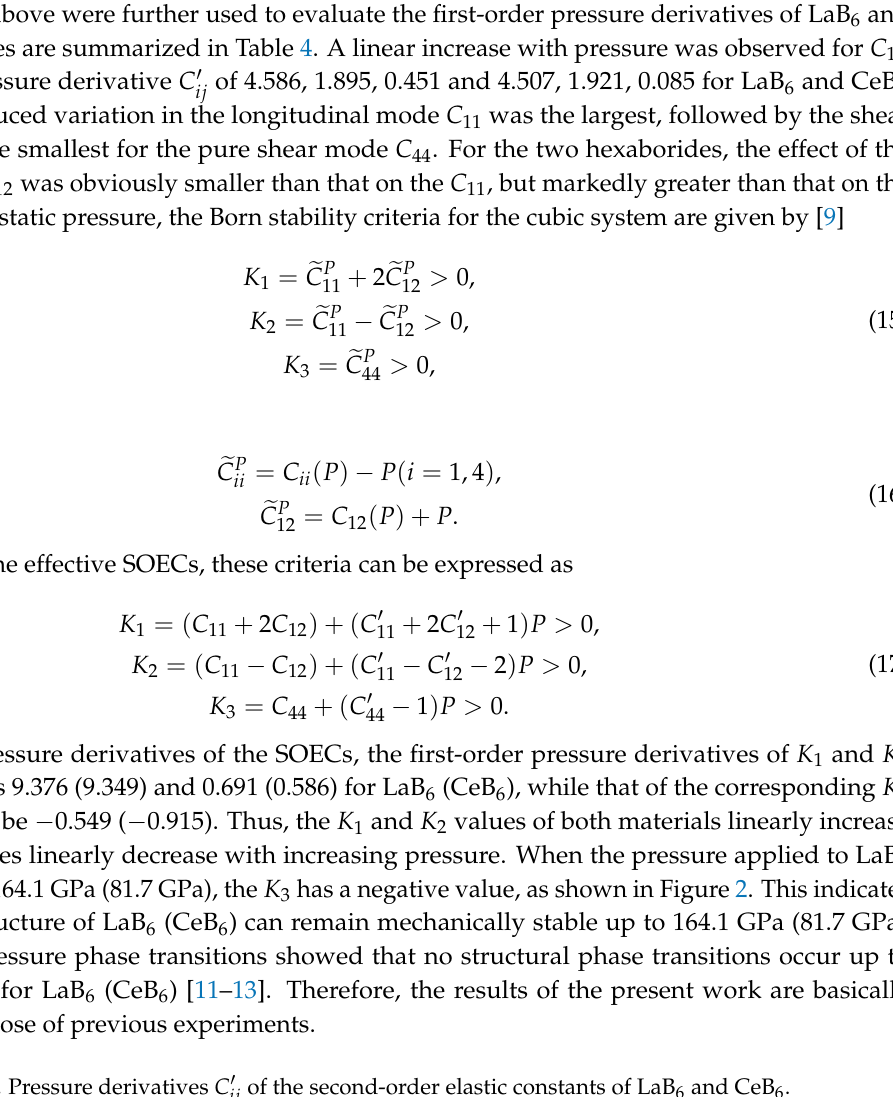
Table 4. Pressure derivatives C (cid:48)